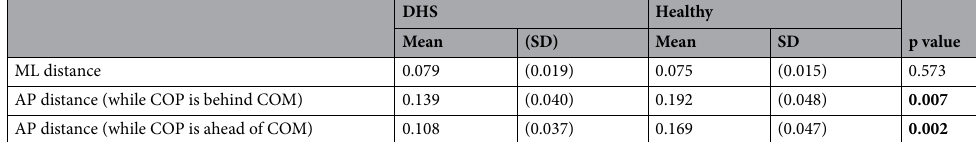
Table 5. Comparison of maximum distance between COM and COP. Bold figure indicate statically significant p < 0.05. Unit is meter. COM Center of mass, COP Center of pressure, DHS Dropped head syndrome, ML Medio lateral, AP